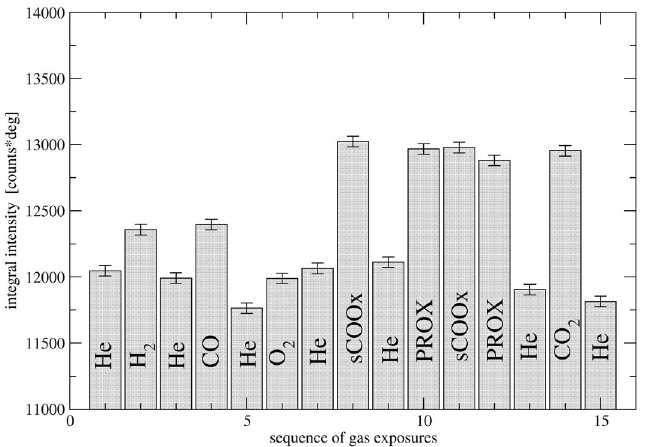
Figure 10. Summary of the Au 111 peak intensity changes during the experimental sequence. Error bars show statistical error.